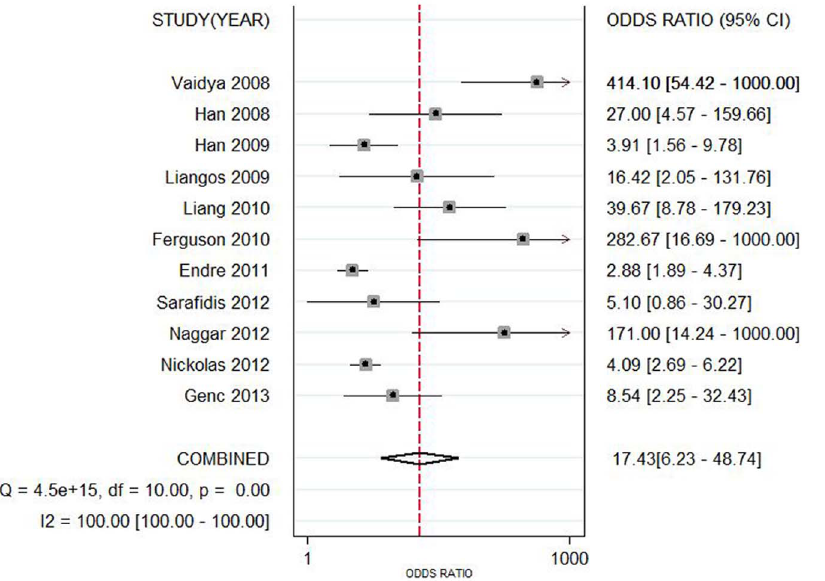
Figure 3. Forest plot of the pooled diagnostic odds ratio of urine kidney injury molecule 1 level in predicting acute kidney injury across all settings. The black squares in the graysquares and the horizontal lines representthe point estimate and 95% confidence interval(CI), respectively. The dotted line represents the pooled estimate, and the diamond shape represents the 95% CI of the pooled estimate.